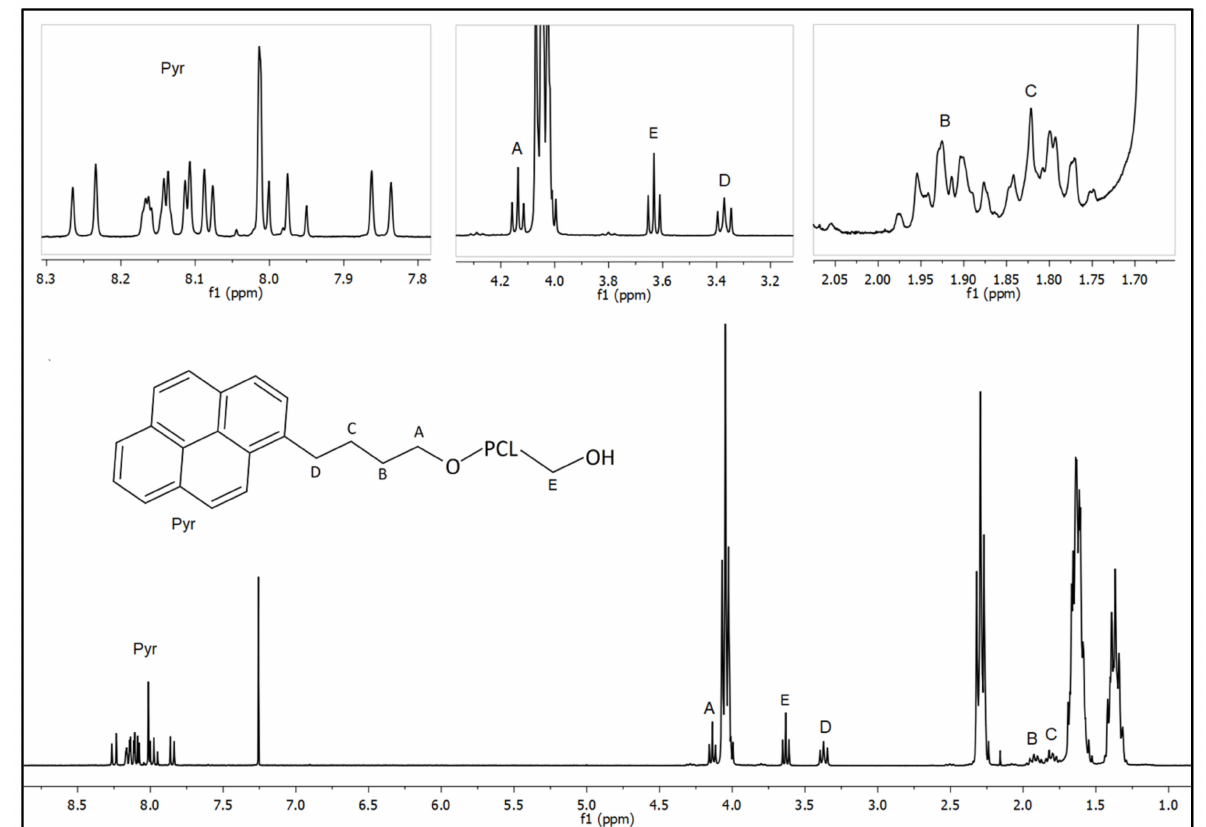
Figure 1. 1 H-NMR spectra of Pyr-PCL in CDCl 3